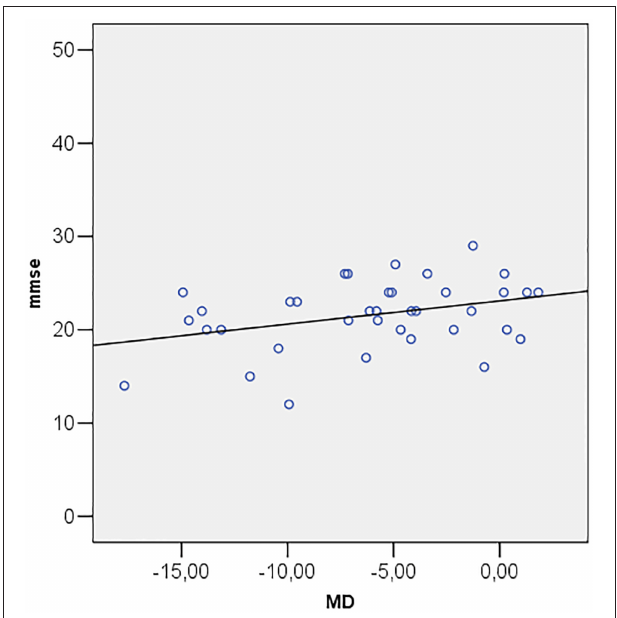
FIGURE 2 | Scatter plot of mini mental state examination (mmse) vs. mean deviation